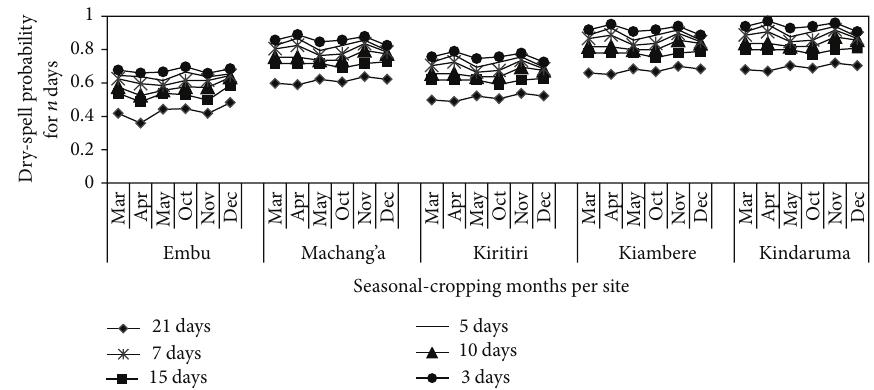
Figure 5: Probability of a dry-spell of length ≥𝑛 days, for 𝑛 = 3 , 5, 7, 15, and 21, in each seasonal-cropping month, based on raw rainfall data from 2000 to 2013 for studied humid and subhumid stations.